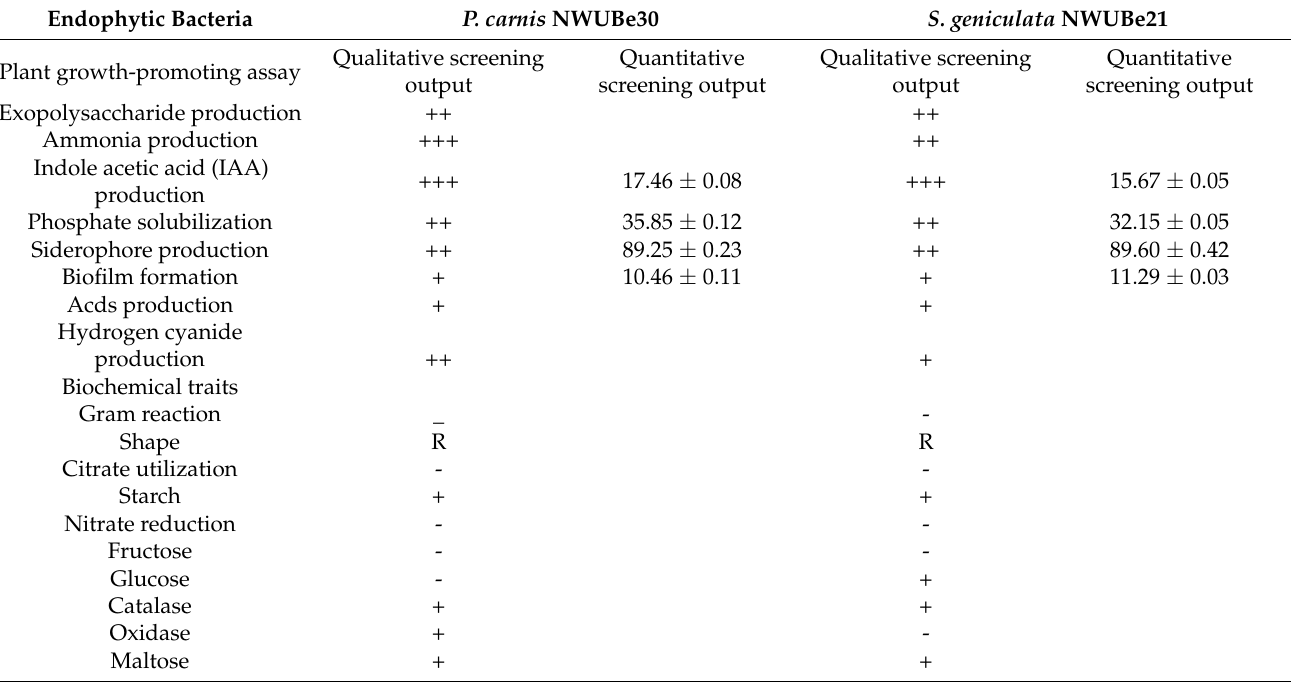
Table 1. Growth promoting in vitro and biochemical attributes of the endophytic bacteria P. carnis NWUBe30 and S. geniculata NWU Be21 strains.